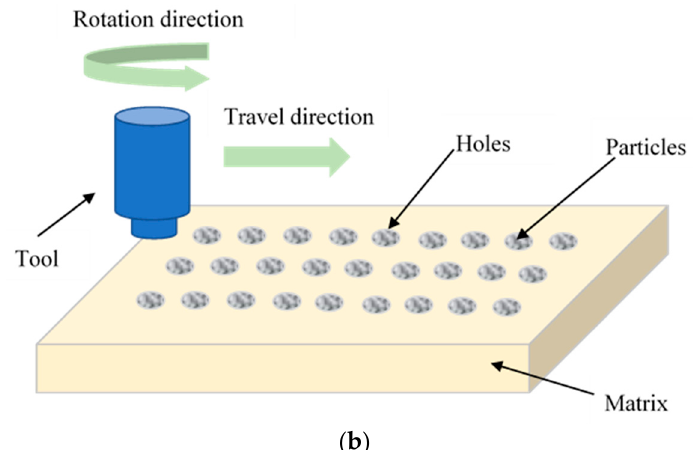
Figure 4. Adding particles methods of fabricating the surface composites: ( a ) groove; ( b ) holes.